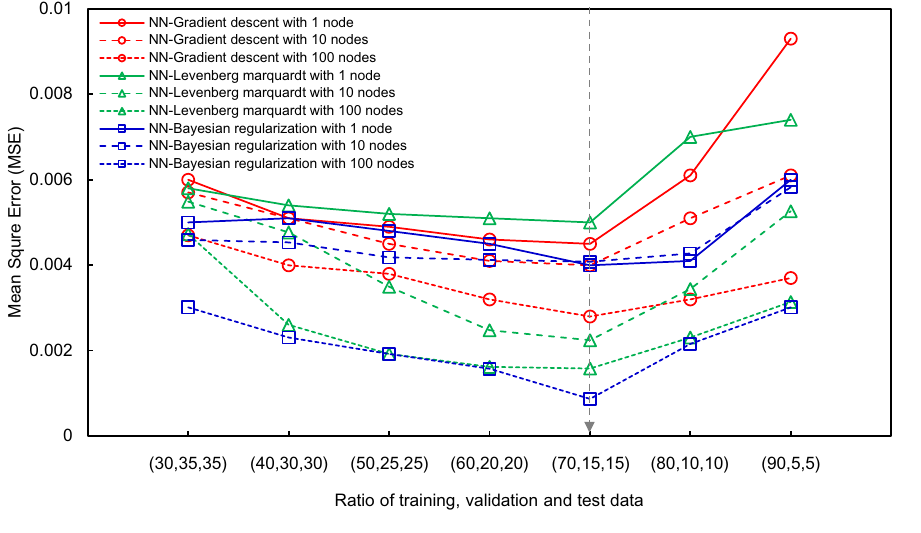
Figure 14. MSE according to selected ratio in neural